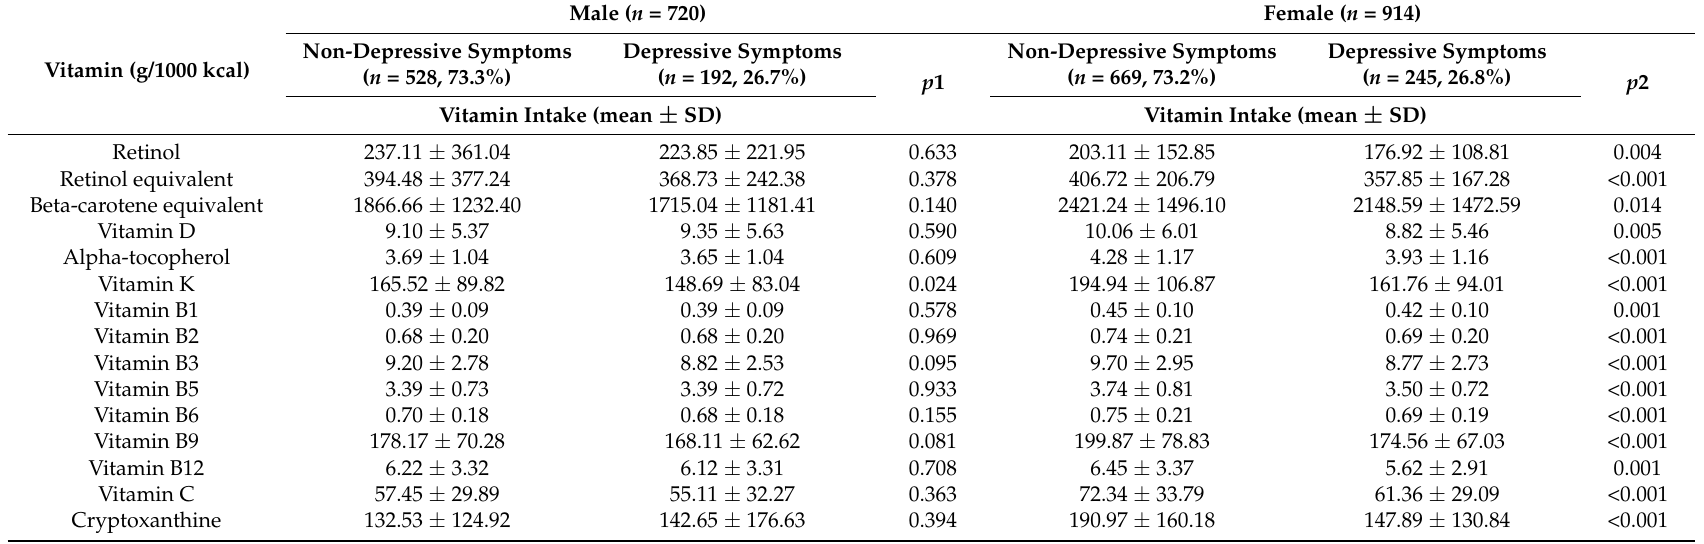
Table 3. Differences in vitamin intake between the groups with and without depressive symptoms by